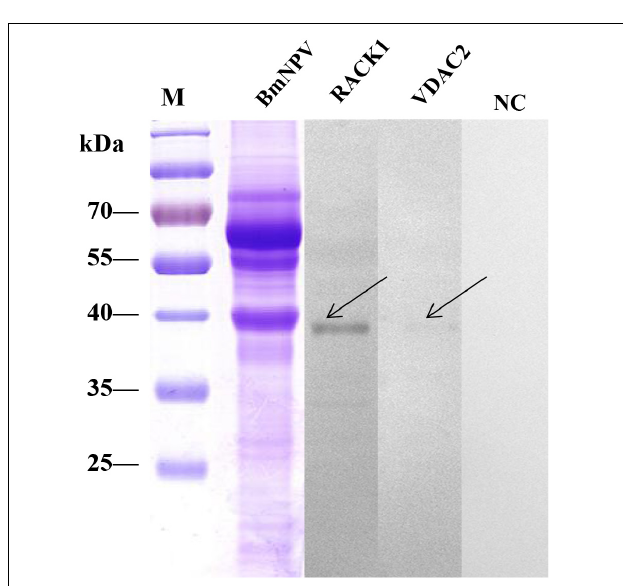
FIGURE 8 | Analysis of the interaction between recombinant proteins and BVs by far western blot. The BVs were overlaid with purified recombinant proteins (RACK1 and VDAC2), and antibodies against His-tagged proteins were used to detect the purified recombinant proteins. M, protein molecular weight marker; NC, negative control, BmNPV incubated with